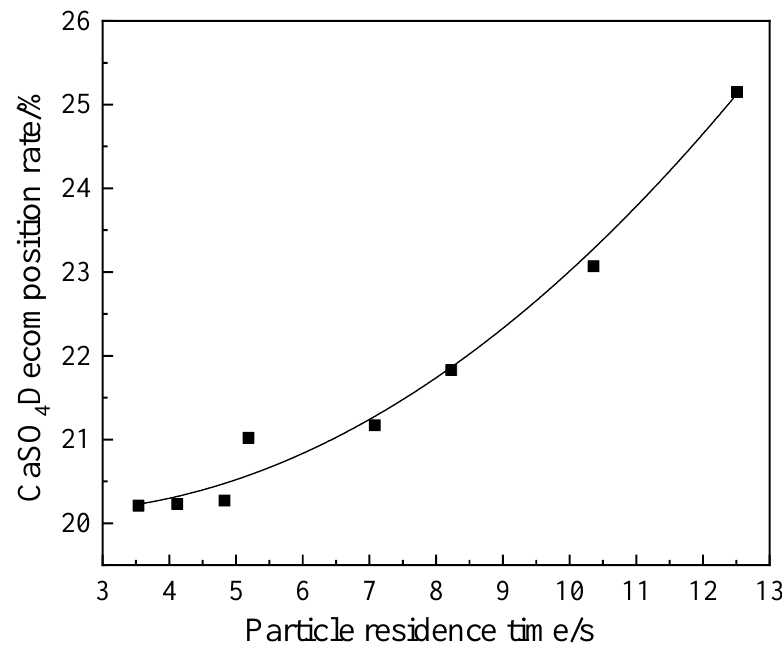
Figure 14. Curve of CaSO 4 decomposition rate with different particle retention times.